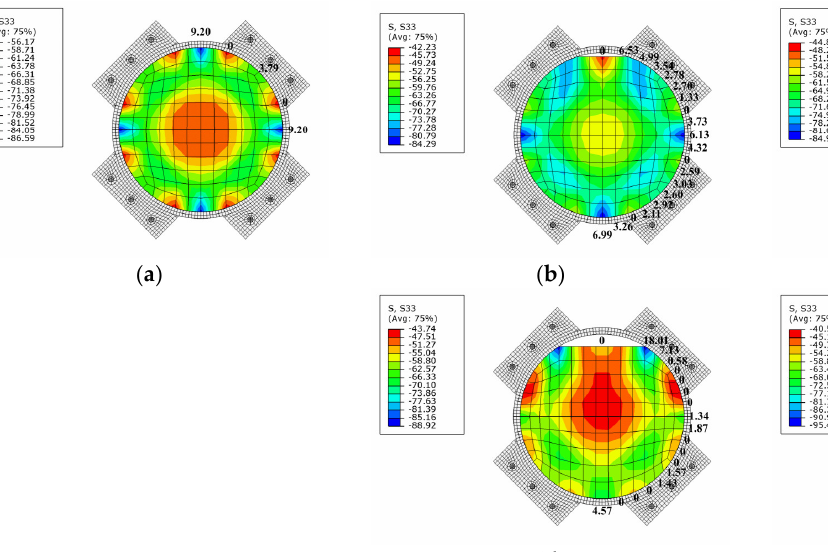
Figure 27. Simulation failure modes of BWCFST short columns with spherical-cap gap of different 